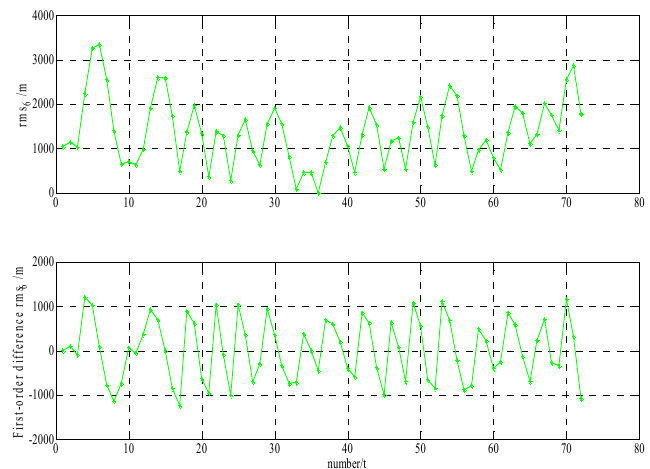
( ) rms t and . ( ) rms t and 6 6 ( ) rms t and 6